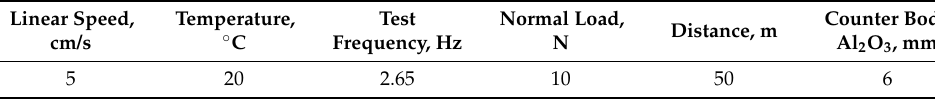
Table 2. The wear test parameters of the “pin-on-disc” method [30]. Linear Speed, cm/s